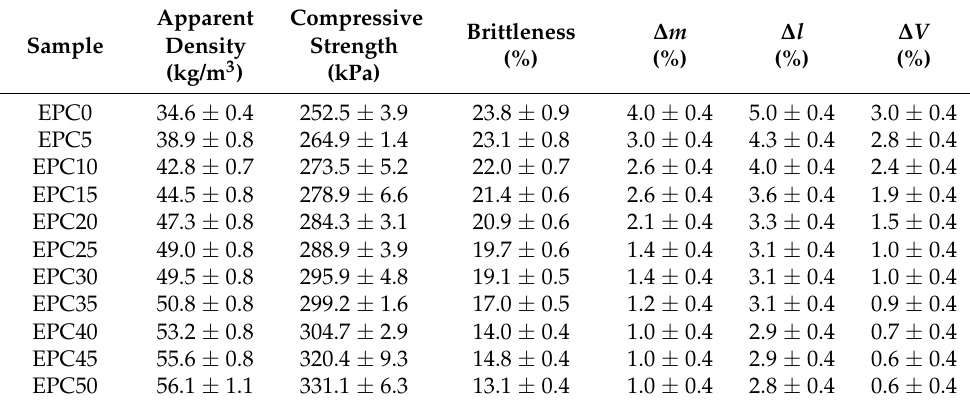
Table 4. Results of physico-mechanical tests and simulated aging